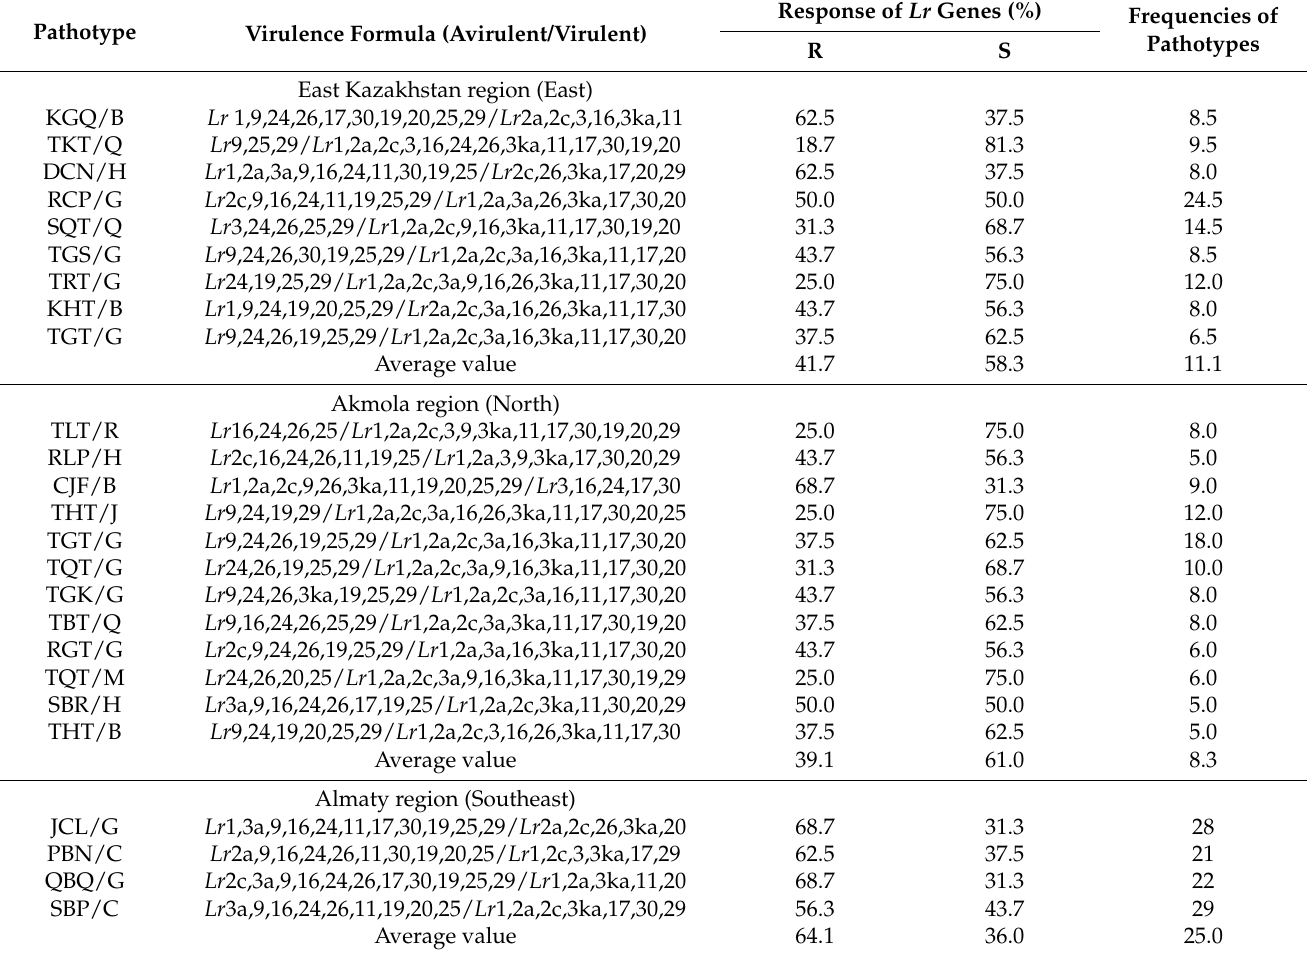
Table 1. Virulence of the 25 pathotypes of P. triticina from different regions of Kazakhstan, determined using a subset of near-isogenic differentials in a Thatcher